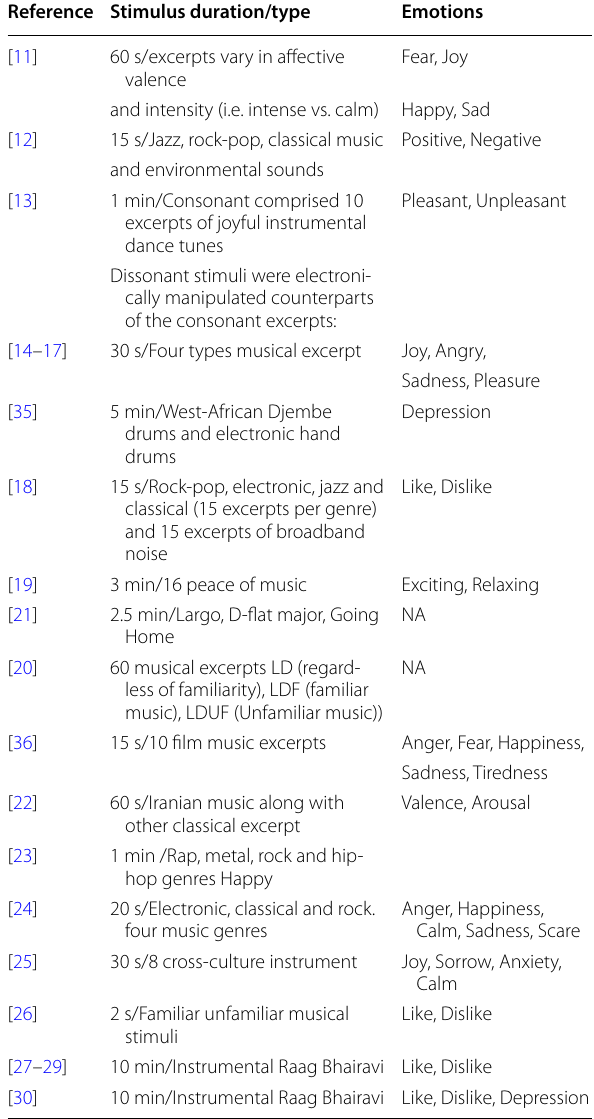
Table 3 Analysis on the basis of stimulus and emotions Reference Stimulus duration/type